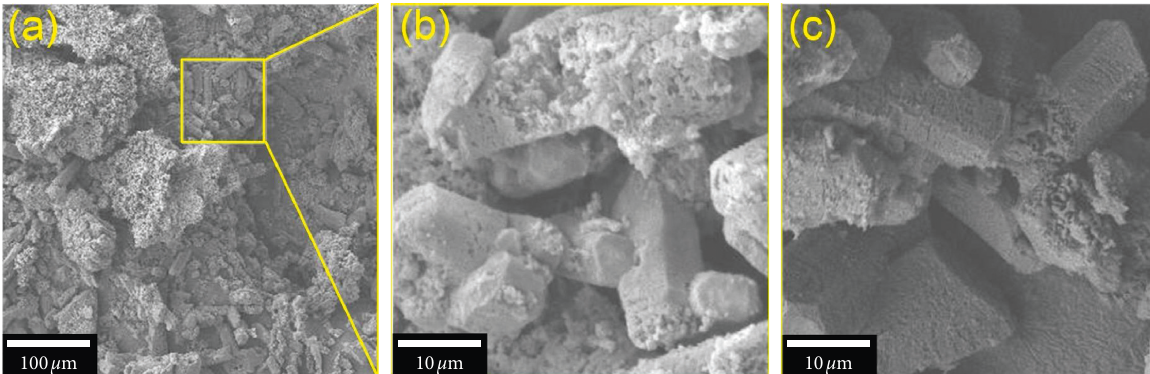
Figure 4: SEM images of MIL-53(Fe) before (a, b) and after refinement (c).